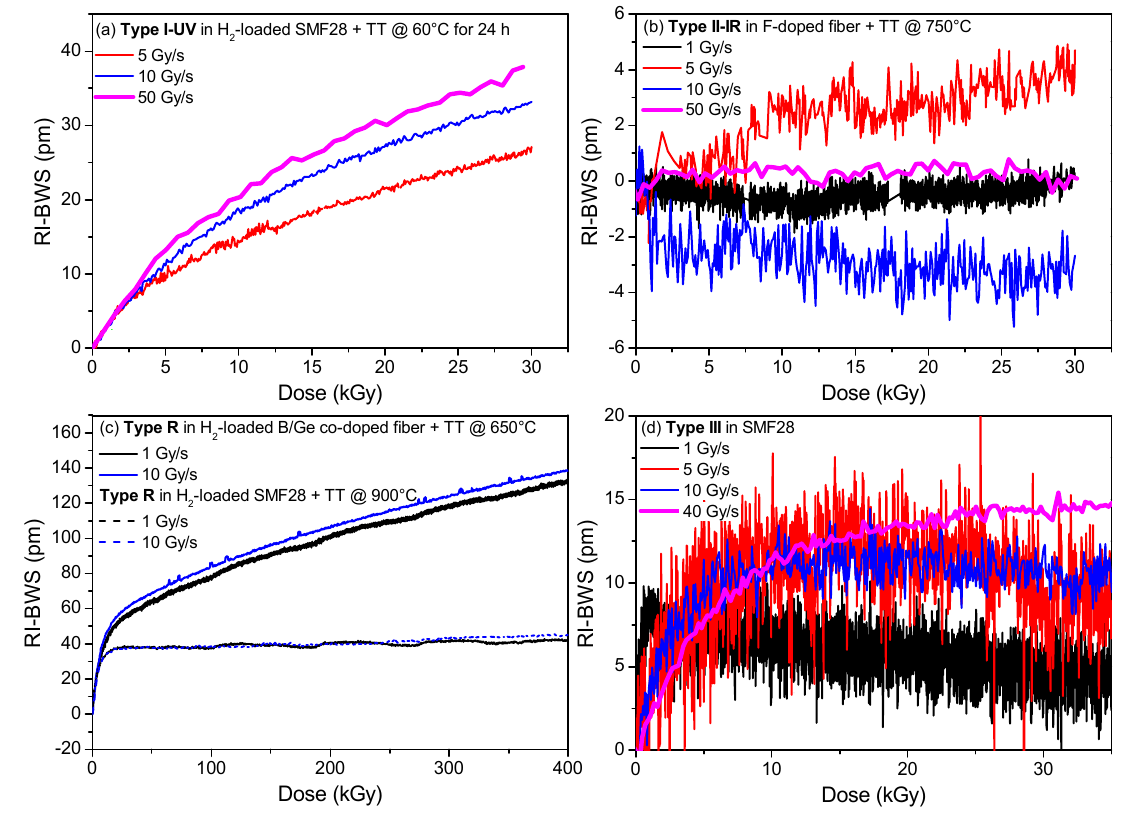
Figure 12. BWS induced by X-rays as a function of the dose, for different dose rates and different FBG types: ( a ) a type I FBG written in an H 2 -loaded SMF28 fiber with a UV CW laser (at 244 nm, power of 120 mW) and treated at 60 °C for 24 h; ( b ) a type II FBG in an F-doped fiber with an fs-IR laser (at 800 nm, a pulse width of 150 fs, and power density of 3 × 10 (cid:2869)(cid:2871) W/cm (cid:2870) ) treated at 750 °C for 15 min; ( c ) type R FBGs in H 2 -loaded B/Ge codoped fiber (continuous lines) or SMF28 fiber (dashed lines) regenerated at 650 °C or 900 °C, respectively; ( d ) a type III in the SMF28 fiber written PbP with an fs-IR laser (at 800 nm, a pulse width < 120 fs, and pulse energy of 230 nJ). Data extracted from [78,81,89,95].